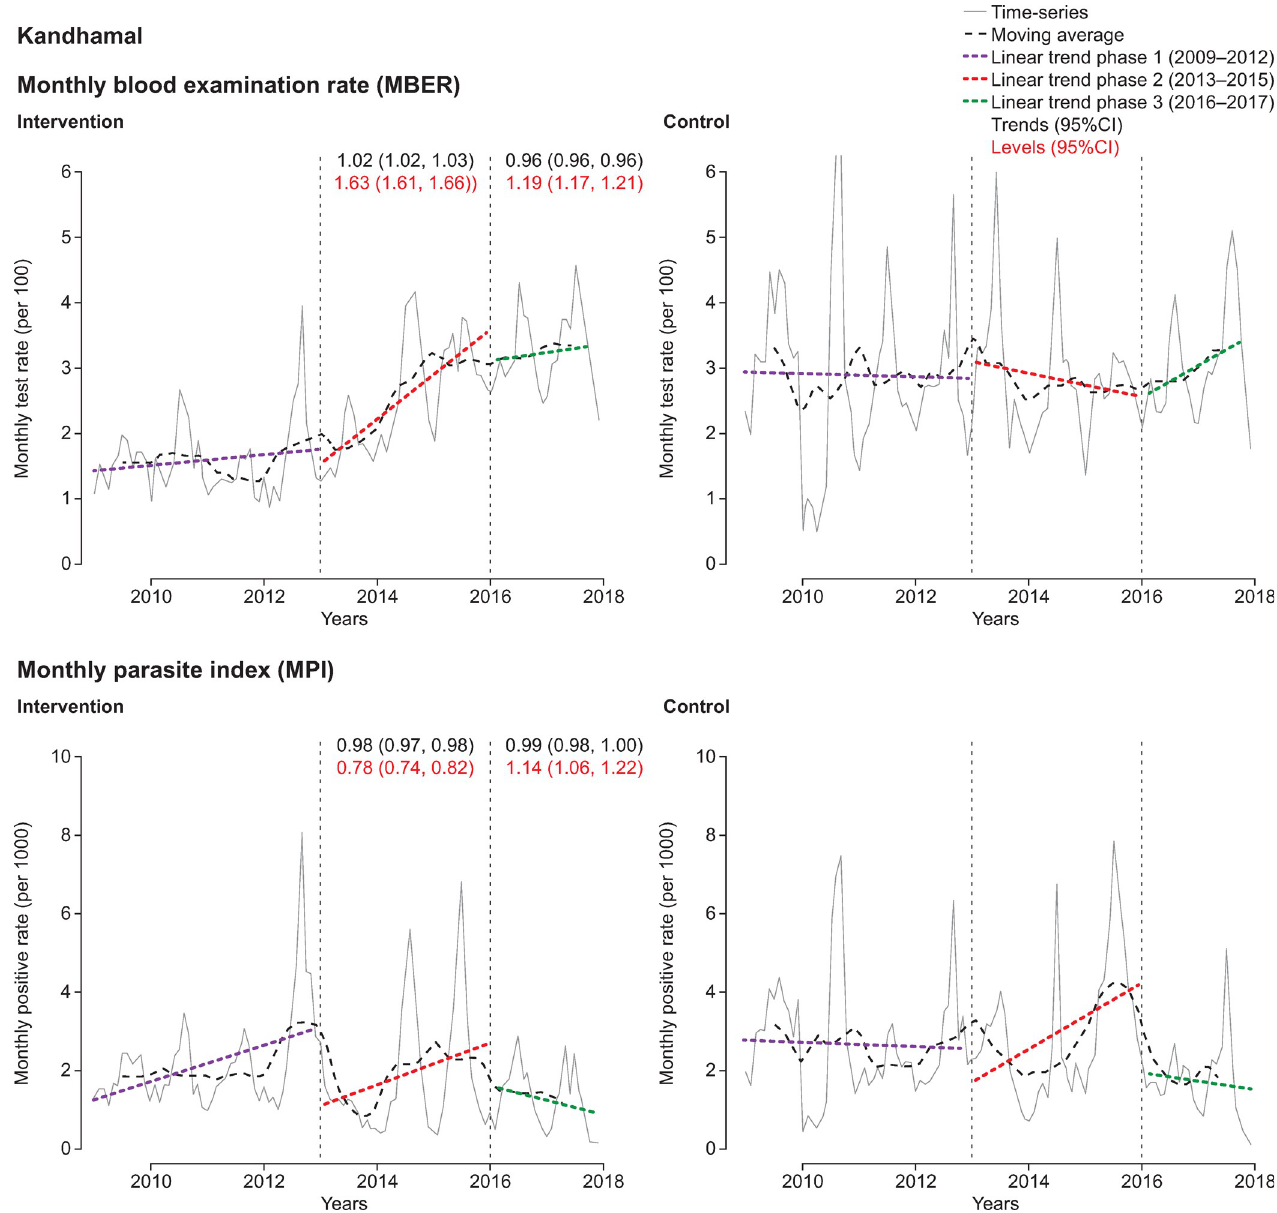
Fig 7. Interrupted time-series analysis of changes in malaria indices for Kandhamal. MBER, monthly blood examination rate = total number of slides examined in a month x1000 / total population; MPI, monthly parasite index = total number of positive slides for parasite in a month x1000 / total population.